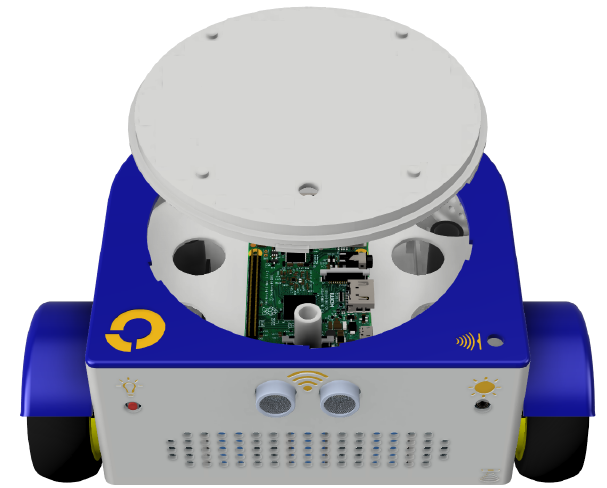
Figure 1. A front top view of the